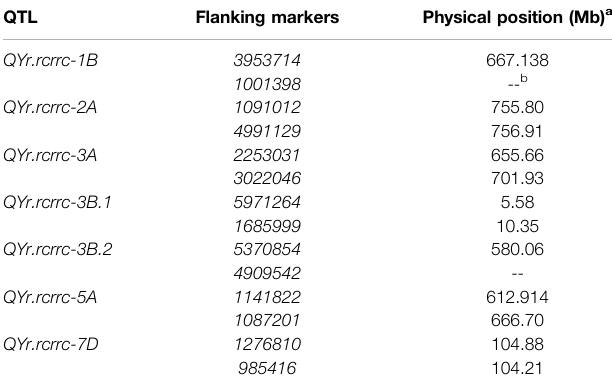
TABLE 4| Physical positionofthe SNPmarkersthat fl ankthequantitativetrait loci (QTLs). QTL Flanking